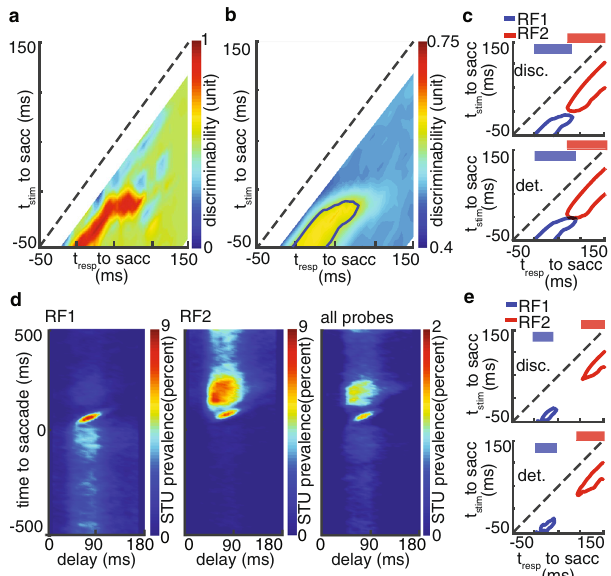
Fig. 2 Quantifying the spatial integration and assessing the contributing perisaccadic modulatory components. a Location discriminability measured via model decoding for a sample MT neuron around its RF1. b Location discriminability around RF1 for the population of 623 neurons. The contour shows where the discriminability exceeds a threshold. c Temporal pro fi les of discriminability (top) and detectability (bottom) for RF1 and RF2; continuous sensitivity is re fl ected in the overlap in the projections on top. Contours indicate the times at which discriminability/detectability were above a certain threshold. d Temporal characteristics of modulated STUs. e Temporal pro fi les of discriminability (top) and detectability (bottom) for RF1 and RF2 after removing modulated